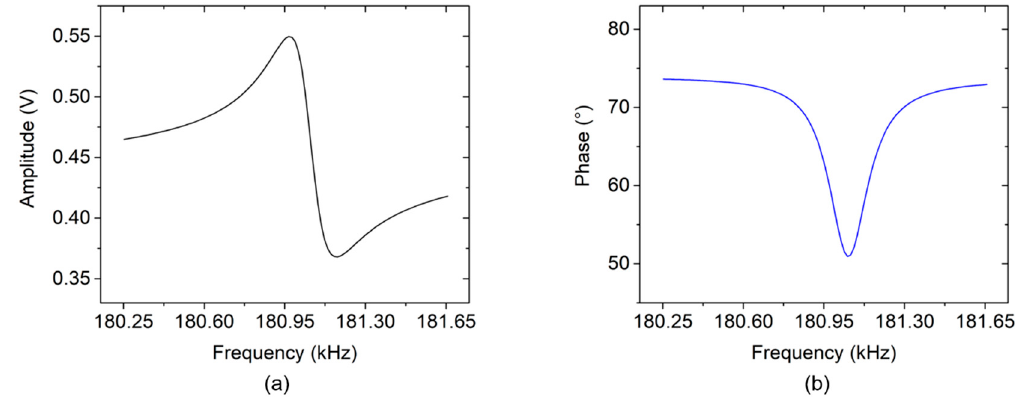
Figure 7. ( a ) Asymmetric amplitude shape and ( b ) a reversed phase response of an electro-thermal piezoresistive cantilever sensor.